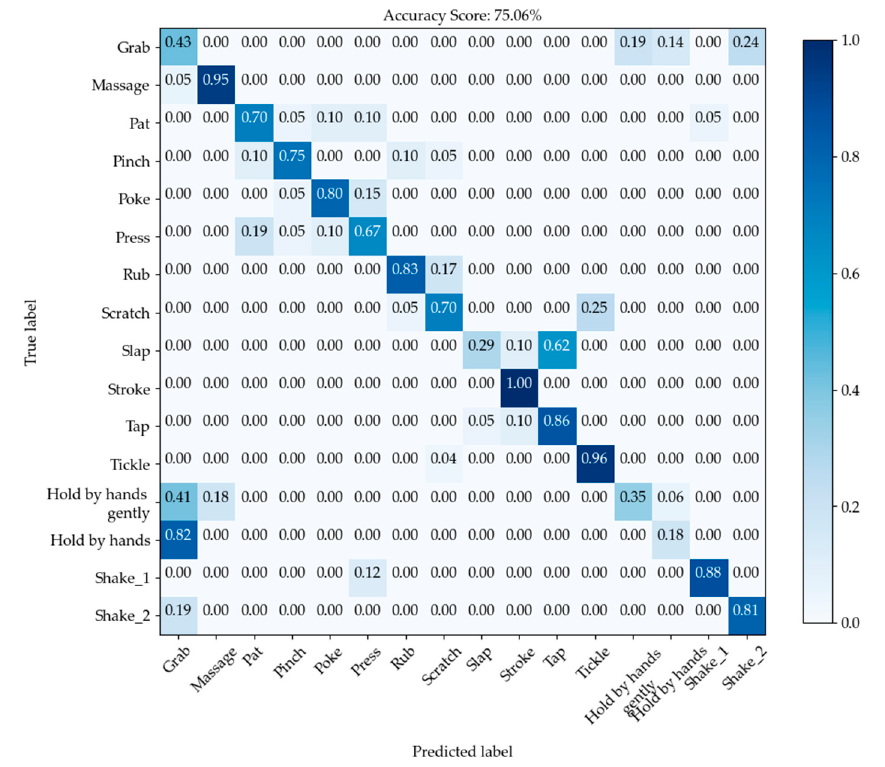
Figure 11. Sixteen touch gesture recognition convolution matrix: Xela robotics tactile sensor, average rate: 75%.